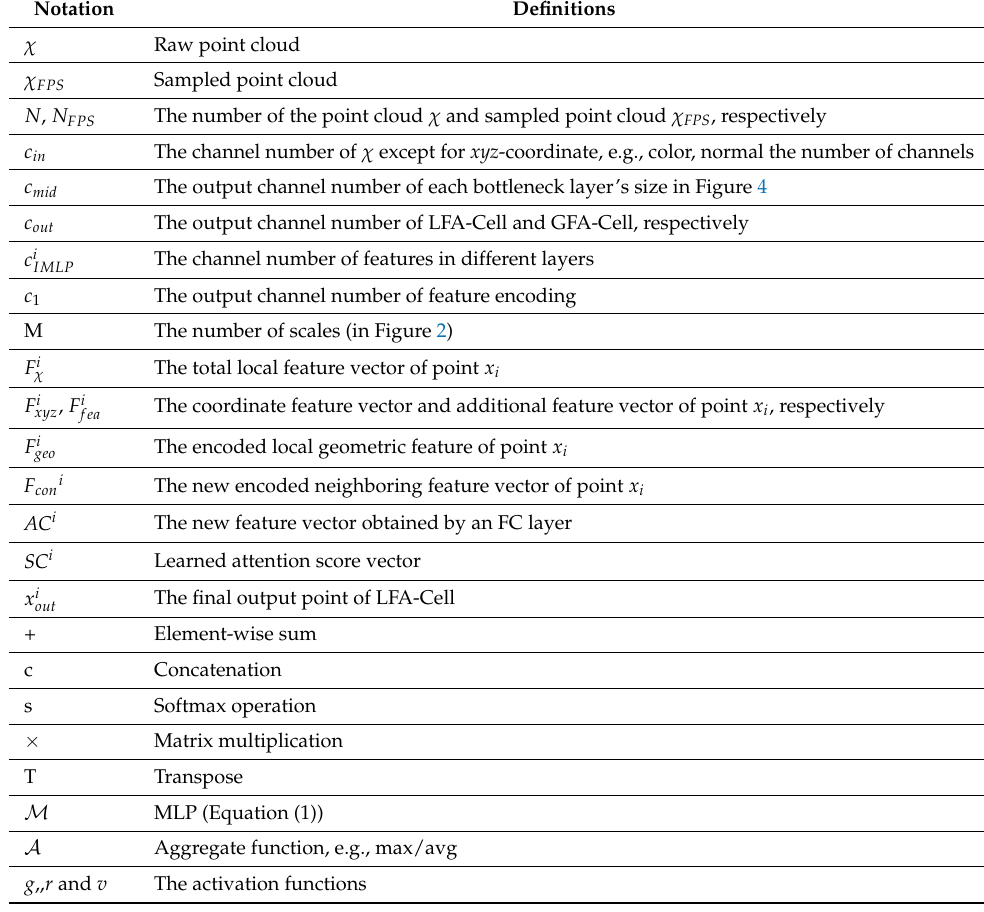
Table A1. Notations and